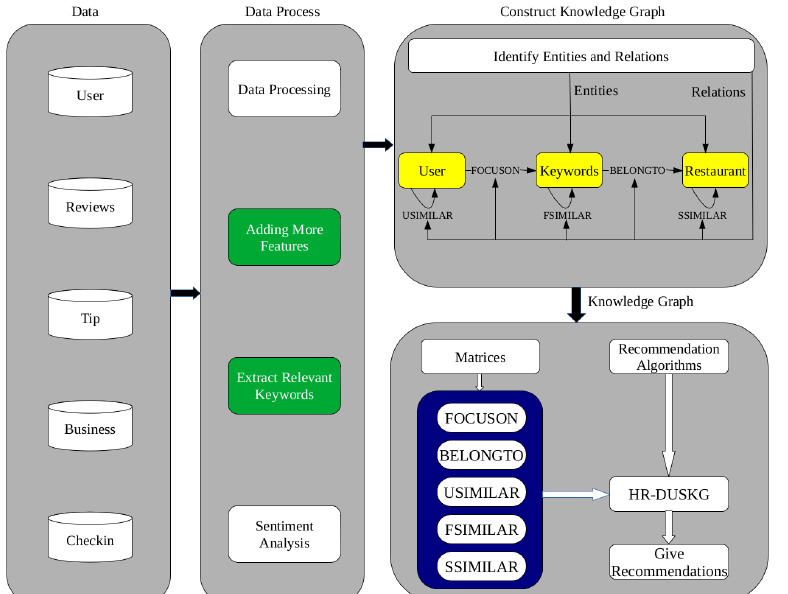
Figure 5. User, restaurant, and keyword extracted from reviews using chunking-based methods are entities and their relations FOCUSON in user-keyword, BELONGTO in keyword-restaurant, and their similarity relations among entities themselves form the knowledge graph in matrices